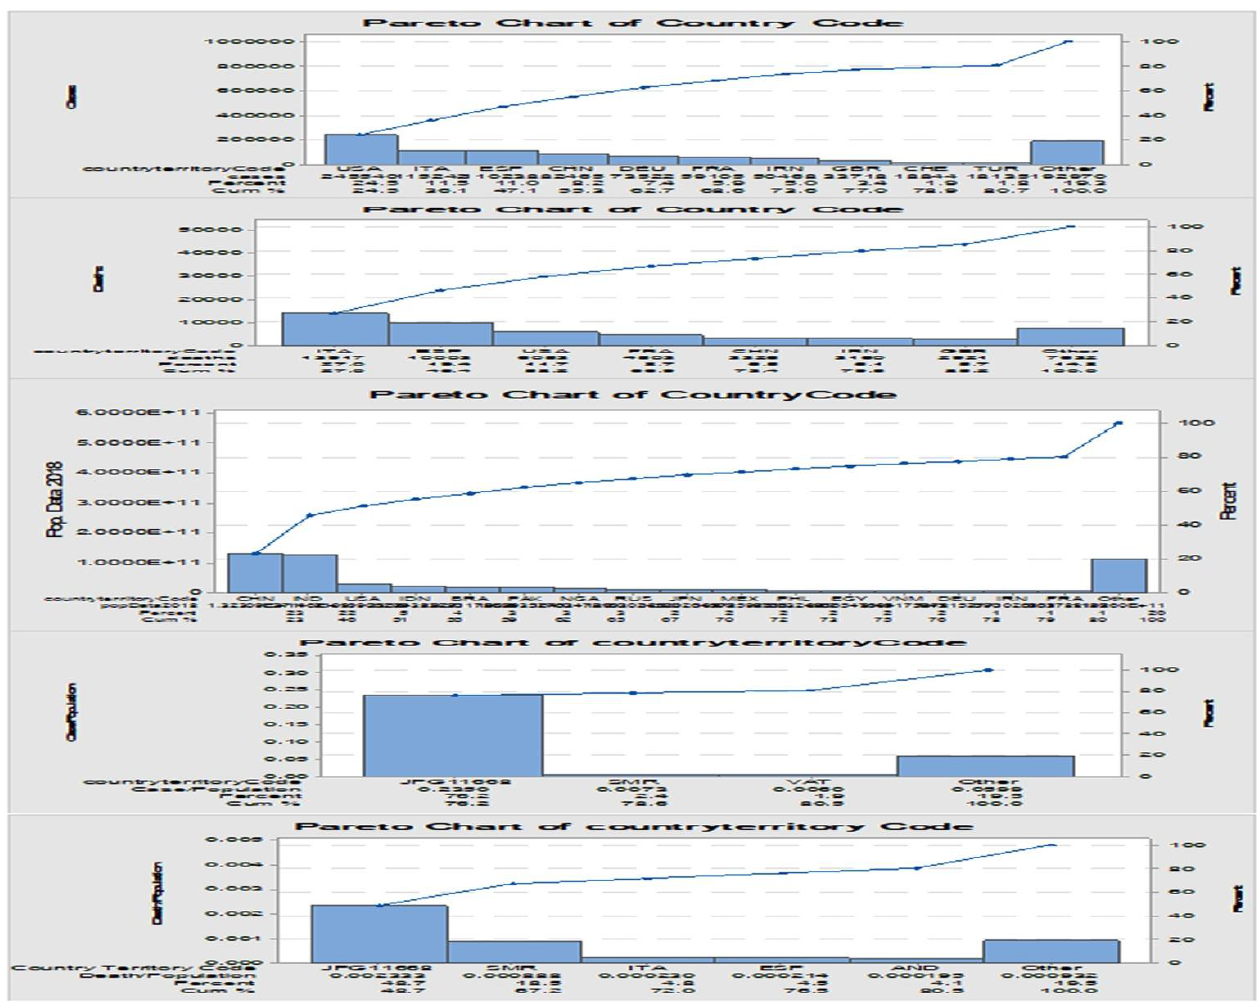
Figure 2: Pareto charts of 80% contributing countries in Corona virus disease 2019 cases, deaths, country-specific morbidities and mortalities rates. ITA: Italy; ESP: Spain; USA: United States of America; FRA: France; CHN: China; IRN: Iran; GBR: Great